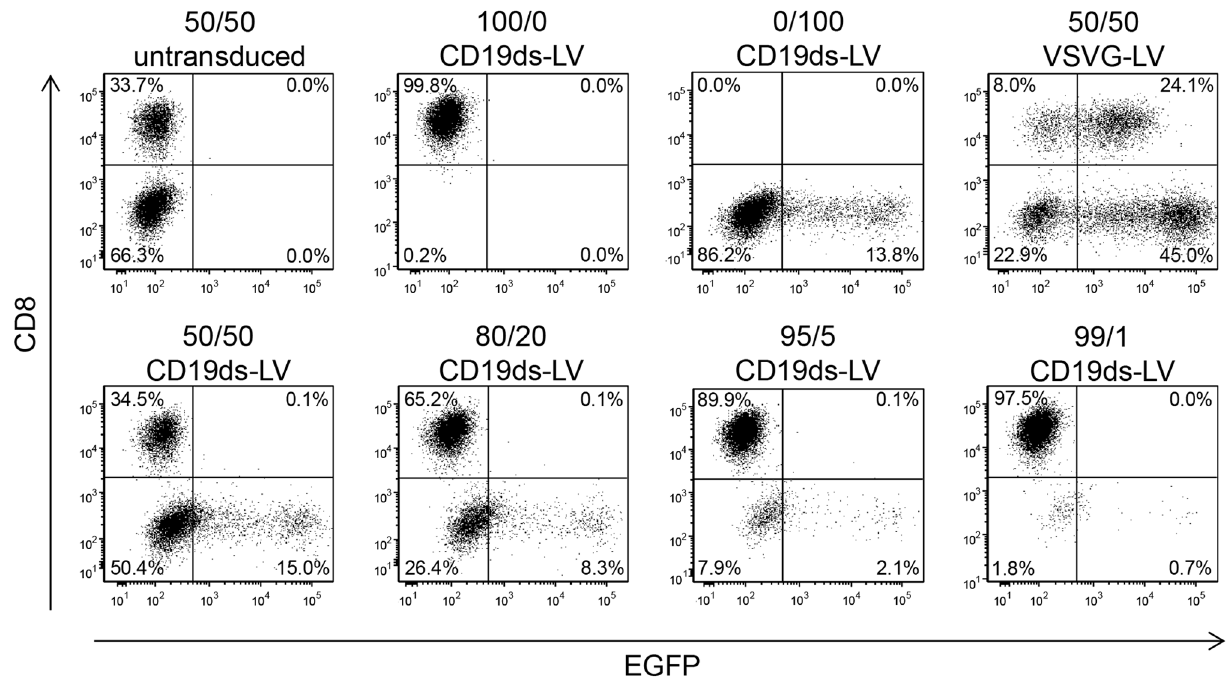
Figure 2. In presence of high numbers of non-target cells CD19ds-LV is specific for CD19 + cells. CD19 2 / CD8 + Molt 4.8 cells were mixed in the indicated ratios with CD19 + /CD8 2 Raji cells and transduced with CD19ds-LV or VSVG-LV vector particles at an MOI of 2 (refers to the total cell number). After 72 h, the cells were stained for CD8 expression and the percentage of EGFP + /CD8 2 cells was determined by FACS analysis. A gating strategy was chosen in which the untransduced cells lay well within the EGFP-negative quadrants as shown in the upper left diagram.